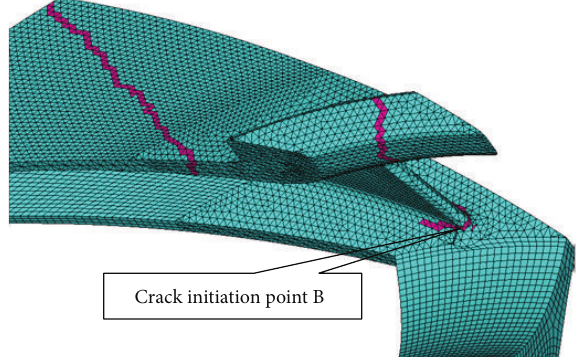
Figure 12: Direction of crack extension near the eye of the impeller (𝑛𝑚 = 1000) .